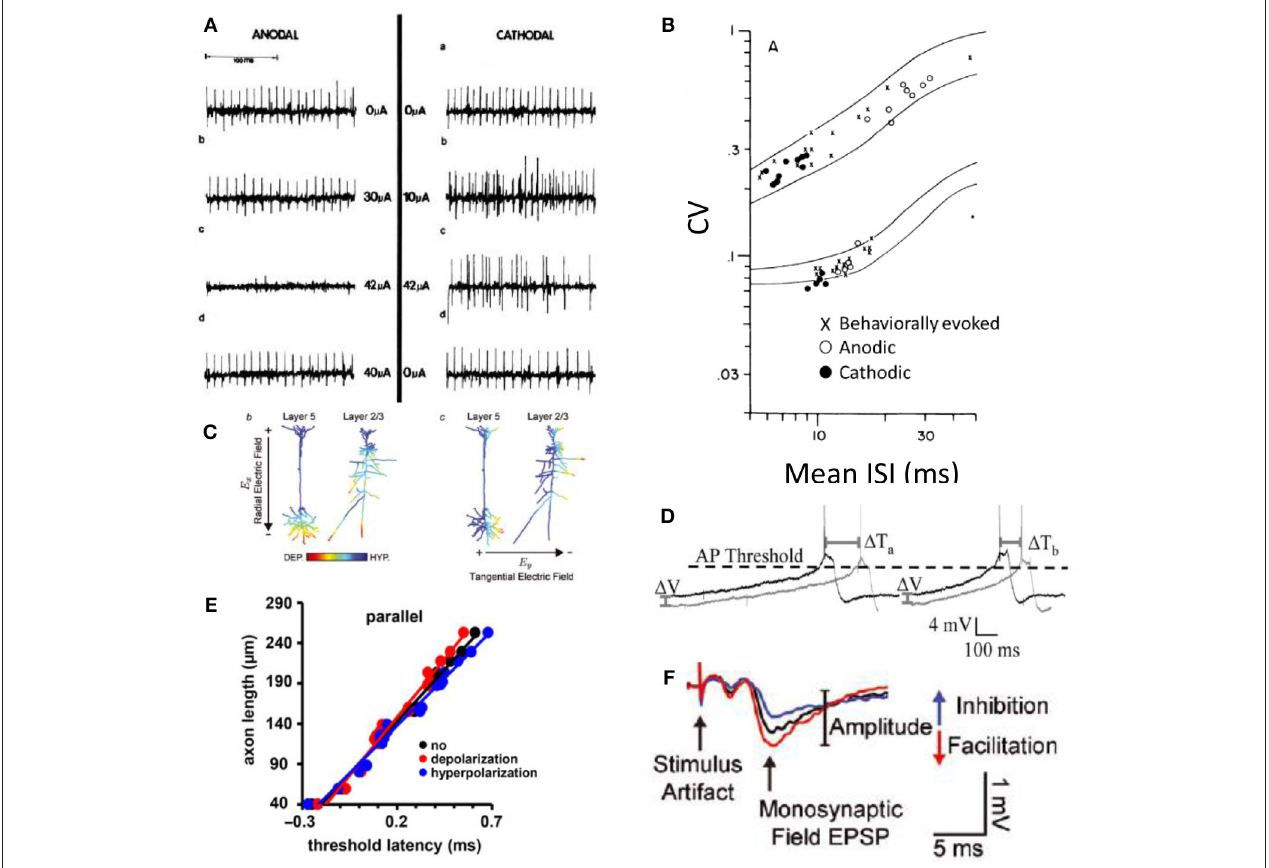
FIGURE 5 | Experimental evidence for the predictions of DC effect on neurons adopted here with permission from the original publications. (A) Small cathodic (–) DC excites and small anodic ( + ) DC suppresses (Hopp et al., 1980). (B) Small cathodic DC excites and small anodic DC inhibits and the stochastic properties of each neuron are maintained as shown in the coefficient of variance (CV) measurement during DC for both cathodic and anodic stimuli (Goldberg et al., 1984). (C) Cortical neural responses to the direction of the DC field is consistent with a monopolar stimulation effect. Cathodic proximity excites (DEP) and anodic suppresses (HYP) ( Rahman et al., 2013). (D) The timing of AP generation is affected by the DC field. Dark lines represent voltage changes during the application of the extracellular DC field ( Radman et al., 2007). (E) Axonal latency of AP propagation plotted when the axon is parallel to the applied DC field. Red is cathodic, blue is an anodic stimulus. Slope of each fitted line corresponds to the conduction velocity in each condition (Chakraborty et al., 2018). (F) DC has a clear effect on the potentiation and depression of synapses as assayed here with an excitatory postsynaptic potential (EPSP) after exposure to the corresponding polarity DC fields ( Rahman et al.,